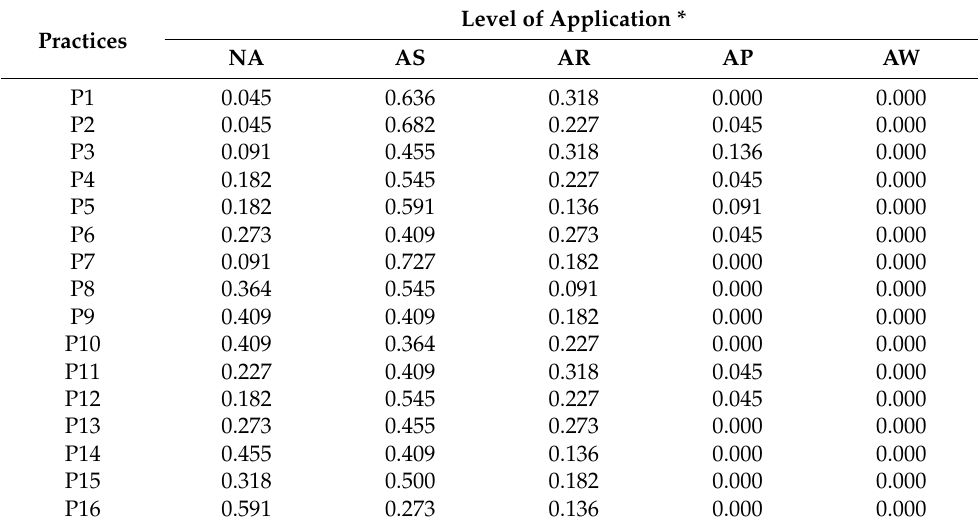
Table 4. Global frequency on the application of each practice in SMIs.